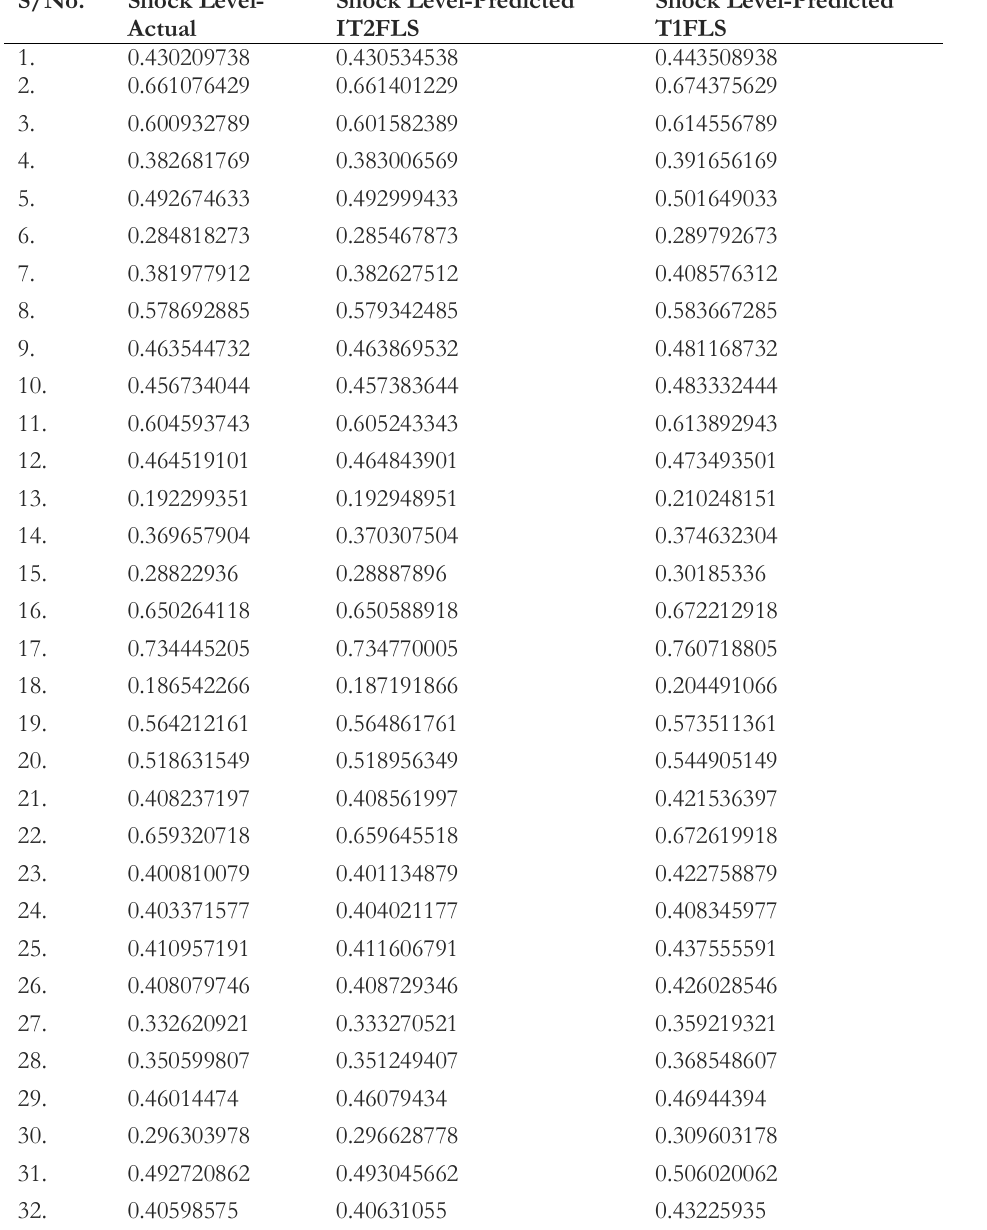
Table 5. Results of shock level actual and predicted for T2FLS and